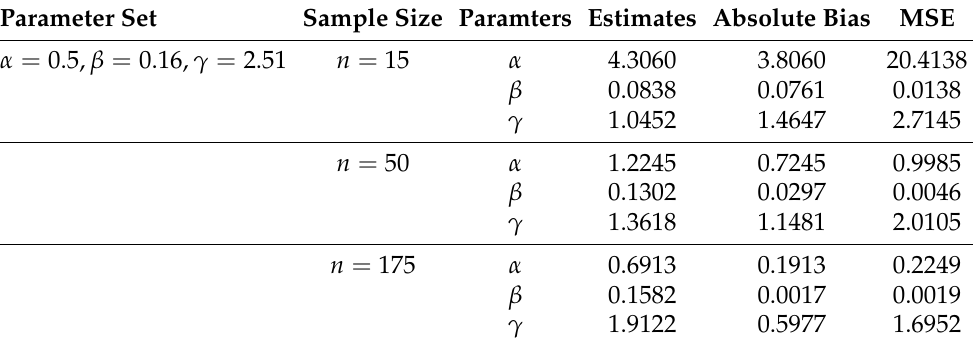
Table 2. The maximum likelihood estimates (MLEs) simulation results for the parameters α , β , and γ . Parameter